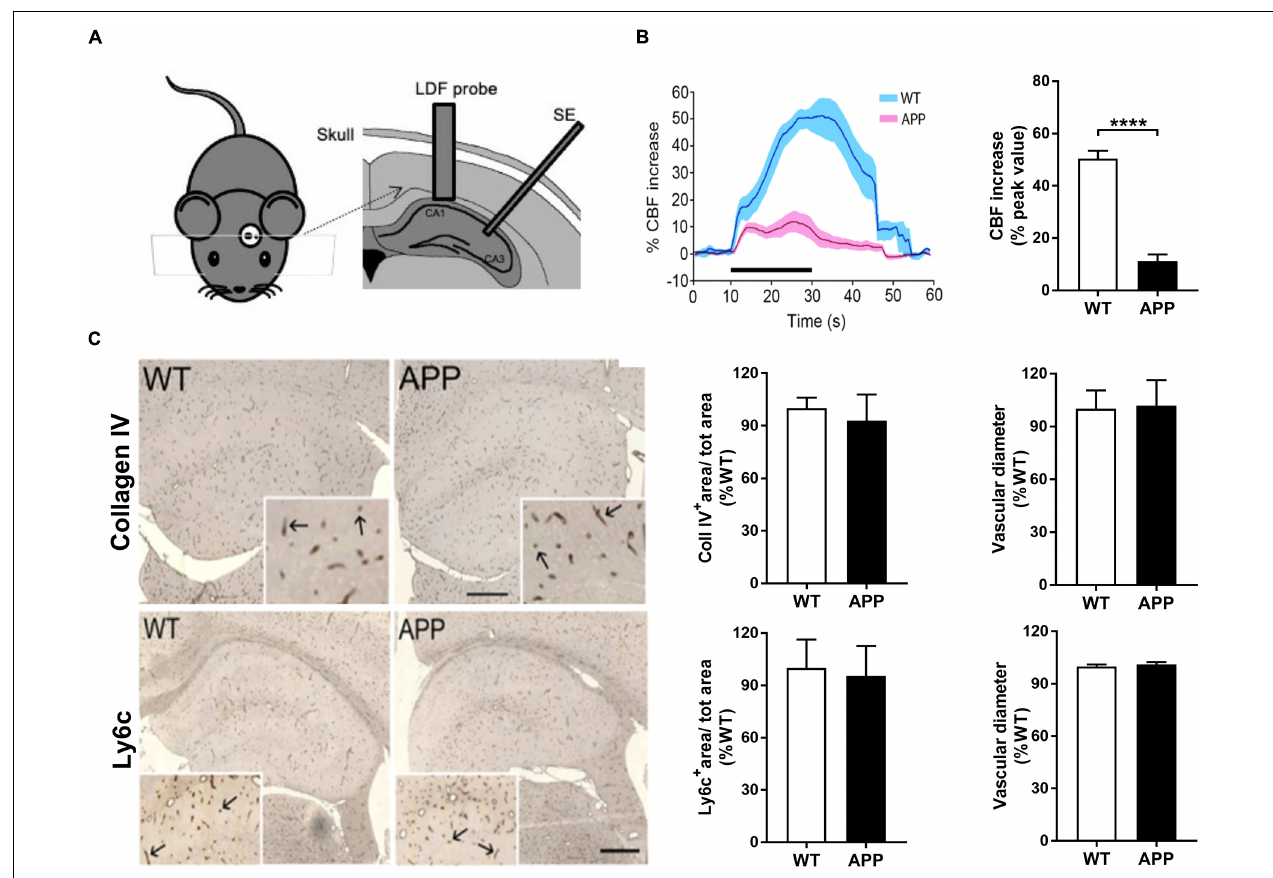
FIGURE 1 | Impaired neurovascular coupling in the hippocampus of APP mice. (A) Schematic drawing of the implantation of the laser Doppler flowmetry (LDF) probe and stimulating electrode (SE). (B) The increase in hippocampal CBF evoked by Schaffer collaterals stimulation (Scs) is reduced in APP mice compared to their wild-type (WT) controls. Left: Traces of averaged evoked CBF responses acquired before, during, and after Scs (WT, blue and APP purple). SEM is represented by the lighter tone shade surrounding each curve. Right: Bar graph of the peak values of evoked CBF responses in WT ( n = 6) and APP ( n = 6) mice, expressed as the percent increase from pre-stimulation (baseline) levels. (C) Hippocampal blood vessel surface area and diameter, respectively, immunostained for collagen IV (upper panel) and Ly6c (endothelial marker, lower panel) in 5 µ m-thick paraffin sections in APP mice mice did not differ from those measured in WT mice. Values are given in percentage of WT. Inserts show higher magnification of the vessels (arrows). Bar = 400 µ m (**** p < 0.0001; two-tailed unpaired t -test, n =